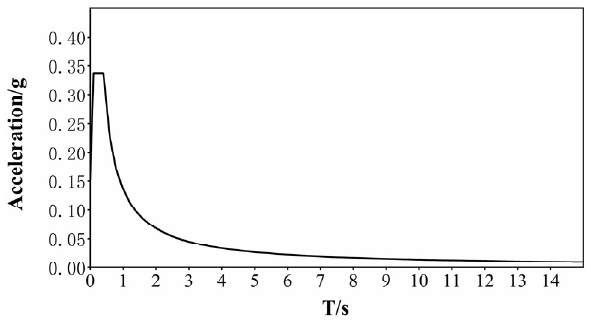
Figure 7. Curve of power amplification factor β .